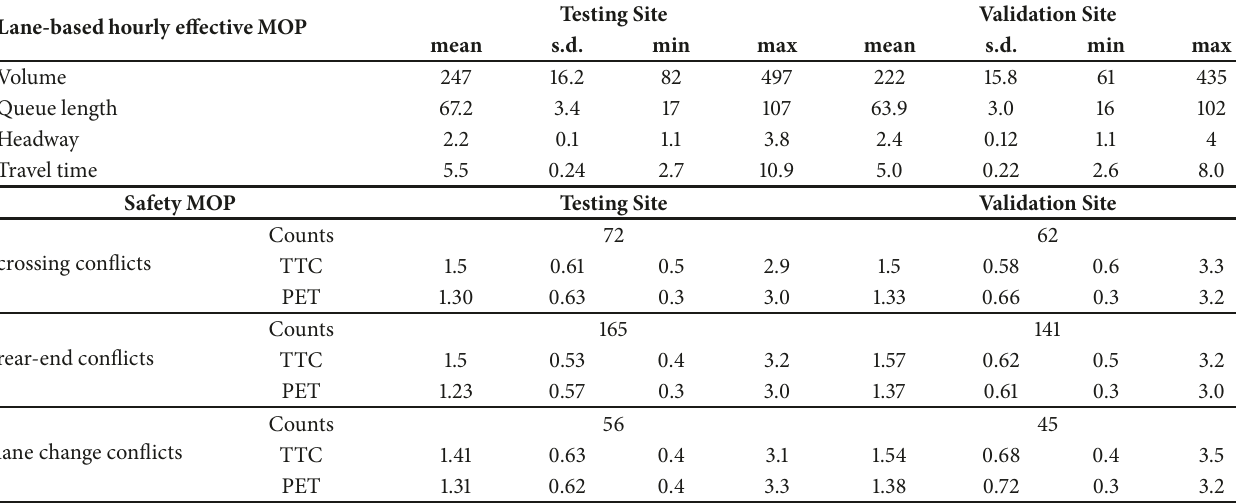
Table 1: Summary statistics of collected traffic and conflict data.